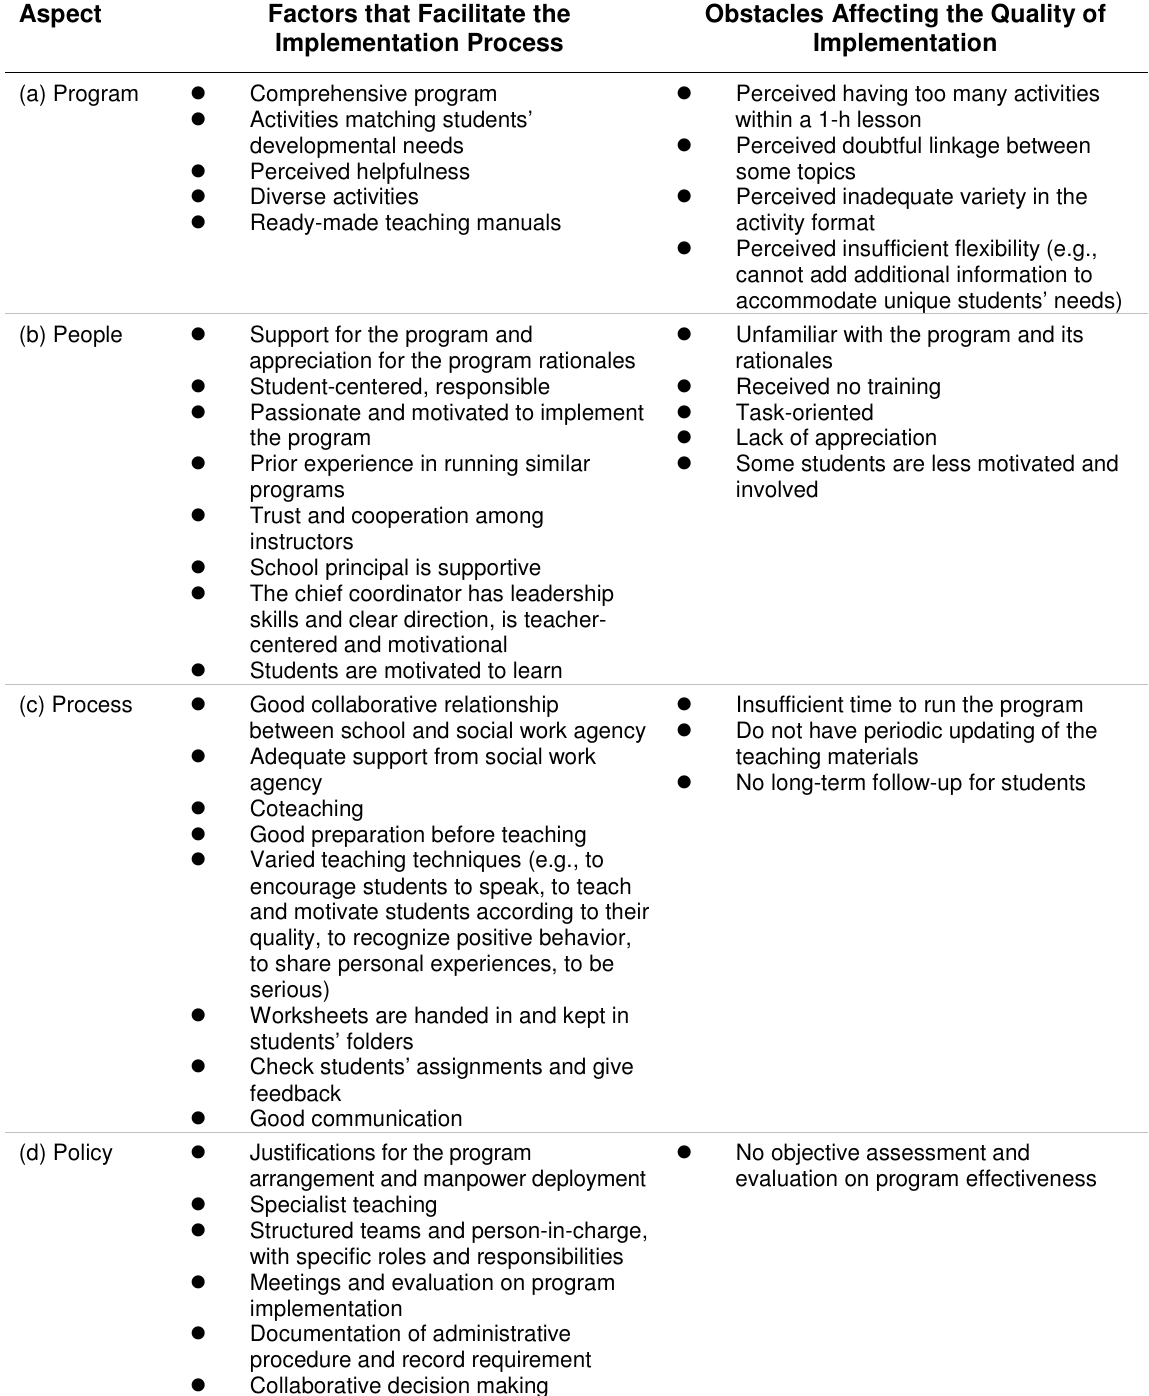
Factors that Facilitate the Implementation Process and Obstacles Affecting the Quality of